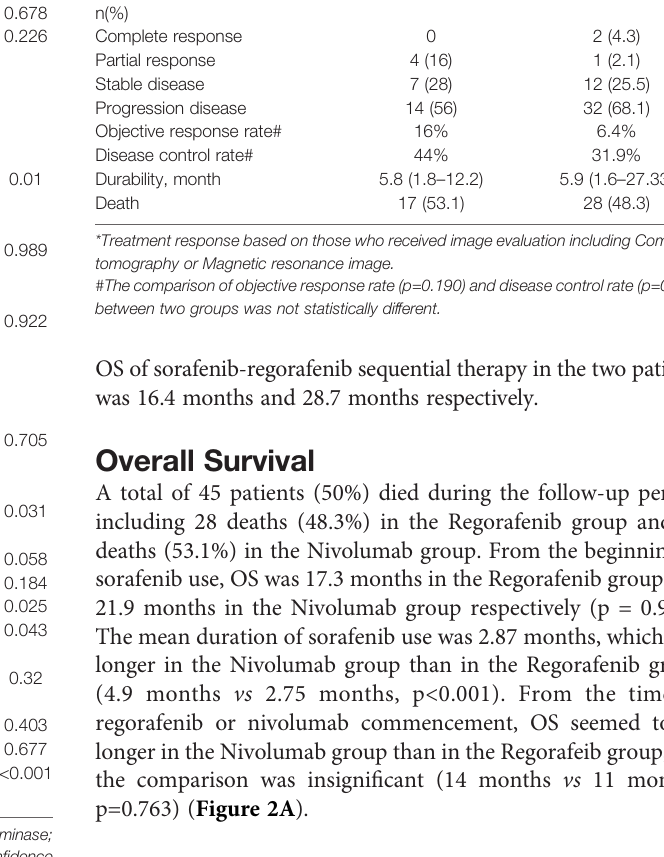
TABLE 1 | Baseline characteristics of the study population by treatment. Variables, n (%) or mean ± S.D